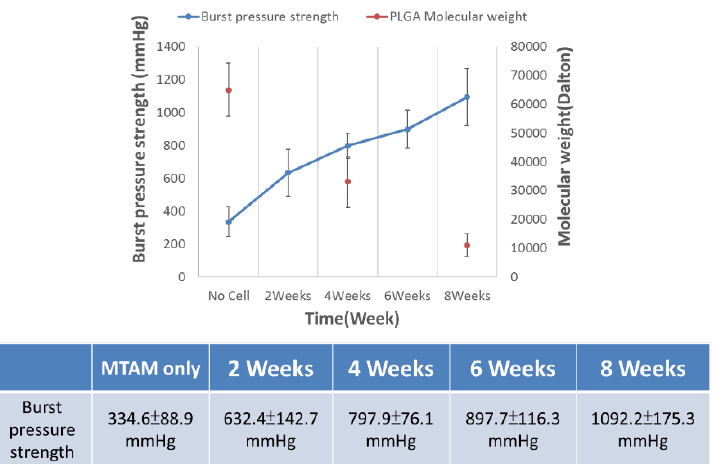
Figure 9. Burst pressure of 2–8 week-old tissue-engineered vascular grafts. The molecular weight of the PLGA registered a significant decrease over the entire eight weeks; on the contrary, the burst pressure increased over the entire duration of the study, ultimately achieving a burst pressure of 1092.2 ± 175.3 mmHg (sample size n = 3).